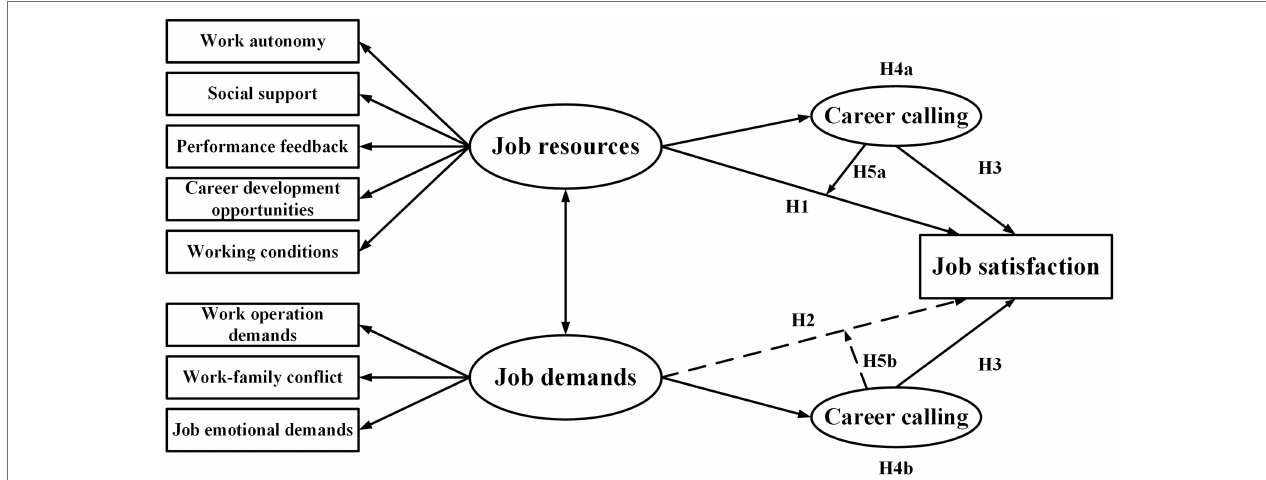
FIGURE 1 | Model for the mechanism of the influence of job demands-resources on job